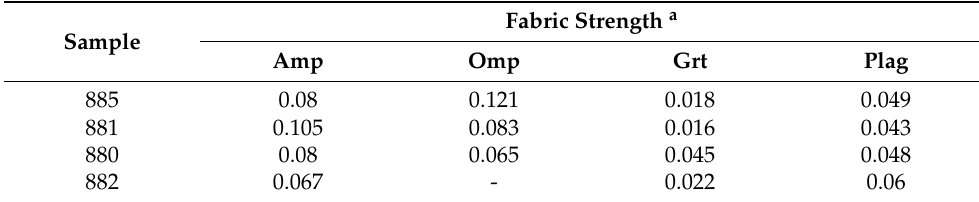
Table 3. Fabric strength of samples.